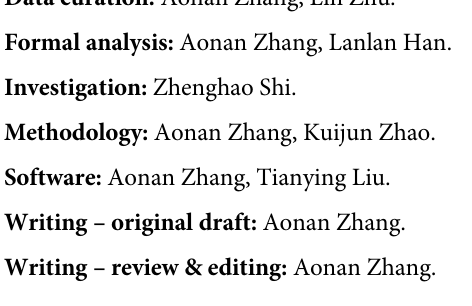
S1 Table. Toxic effects of imidacloprid and thiamethoxam on the first instar nymphs of A . glycines . SE = standard error. S2 Table. Mean value ( ± SE) of life history parameters of A . glycines exposed to imidaclo- prid and thiamethoxam. Means ( ± SE) followed by different letters in the same row are signifi- cantly different as calculated using the paired bootstrap test at the P < 0.05 level. Leaves treated with distilled water were used as the control. SE = standard error; L1 = mean longevity of the first instar nymphs; L2 = mean longevity of the second instar nymphs; L3 = mean lon- gevity of the third instar nymphs; L4 = mean longevity of the fourth instar nymphs; Fecundity = mean fecundity per female adult. S3 Table. Mean value ( ± SE) of fertility parameters of A . glycines exposed to imidacloprid and thiamethoxam. Means ( ± SE) followed by different letters in the same row are signifi- cantly different as calculated using the paired bootstrap test at the P < 0.05 level. Leaves treated with distilled water were used as the control. SE = standard